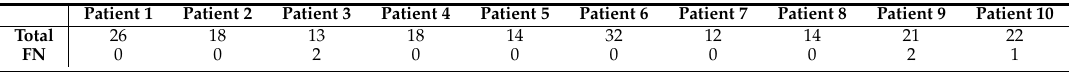
Table 8. Activity recognition for DMD recordings: false negative rates during running